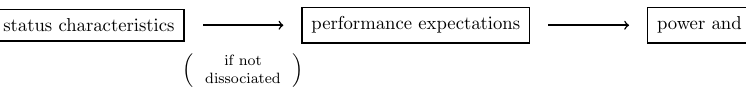
Figure 1: Graphic representation of the core argument of